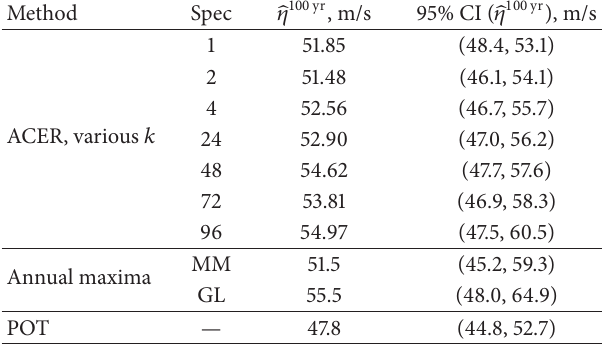
Table 2: Predicted 100-year return period levels for Nordøyan Fyr weather station by the ACER method for different degrees of conditioning, annual maxima, and POT methods,